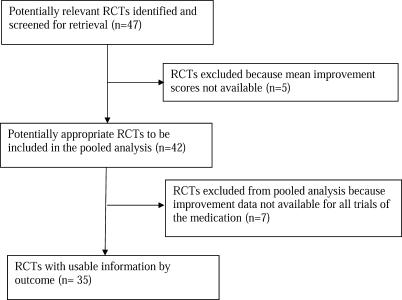
QUOROM Flow Chart